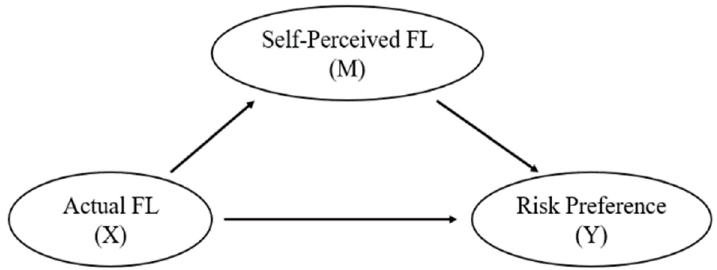
Figure 1. X-M-Y triangle relationship.